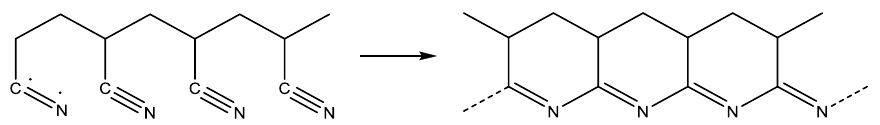
Scheme 2. Cyclization initiated by radical